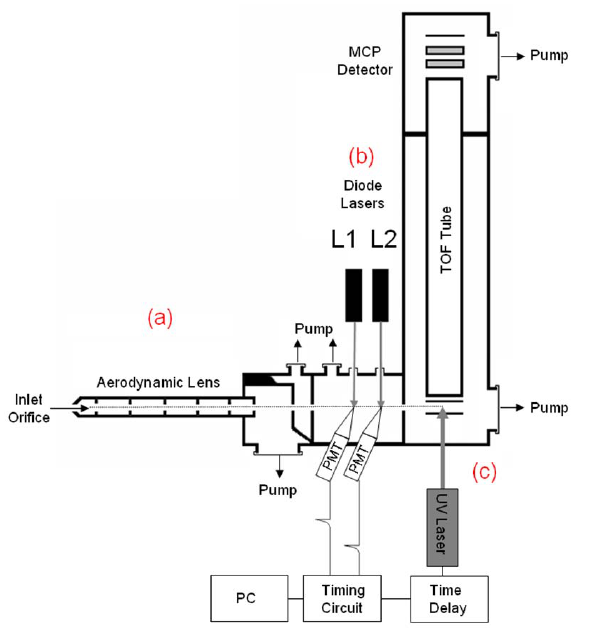
Fig. 1. Schematic illustration of the Single Particle Laser Ablation Mass Spectrometry (SPLAM) instrument: (a) particles are focused by an aerodynamic lens system, (b) the particle beam crosses two continuous diode laser beams allowing optical detection of individual particles and determination of their respective aerodynamic diameter, (c) an external timing circuit permits to trigger a UV laser to vaporize and ionize individual particles. The formed ions are analyzed by the time-of-flight mass